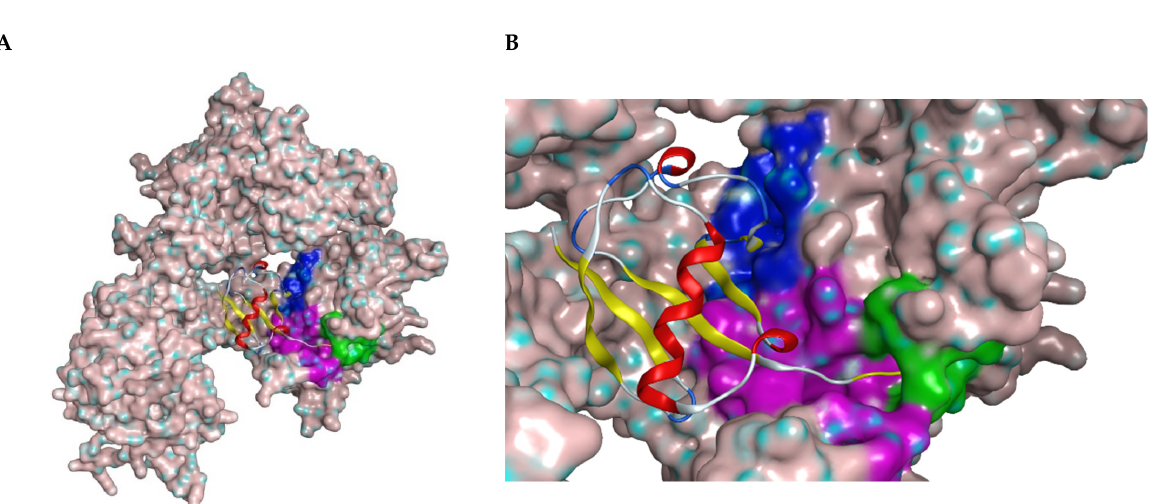
Figure 1. ( A ) Structure of USP7 catalytic domain in complex with ubiquitin (PDB ID: 1NBF). The molecular surface was added. The ribbon model represents ubiquitin molecule. ( B ) Closer look of the binding region of USP7 inhibitors. The green surface depicts the catalytic center; the purple surface depicts the cleft between the Thumb and Palm domains; the blue surface depicts the allosteric binding site.